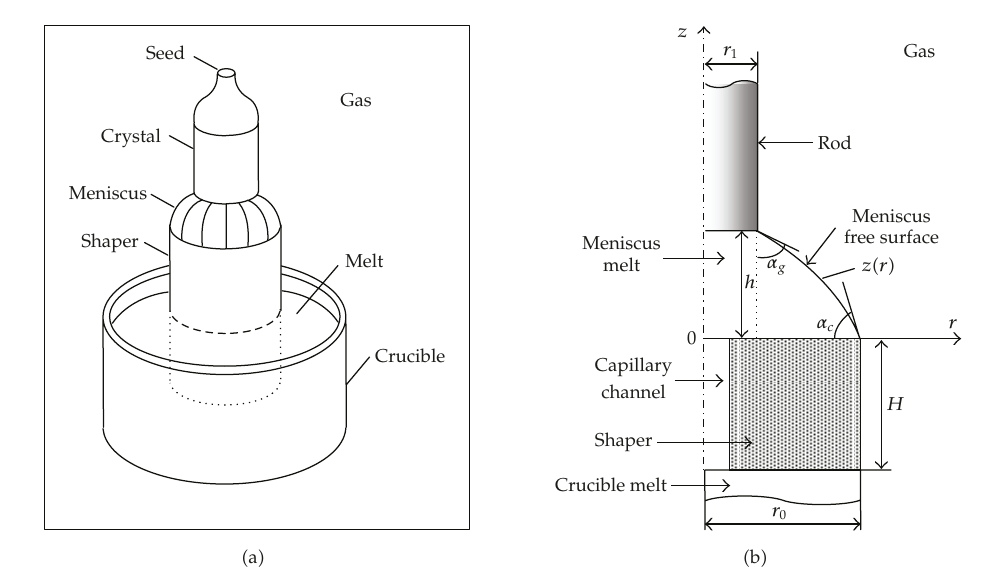
Figure 1: Axisymmetric meniscus geometry in the rod growth by EFG